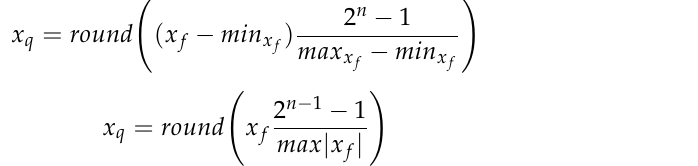
) with the same i